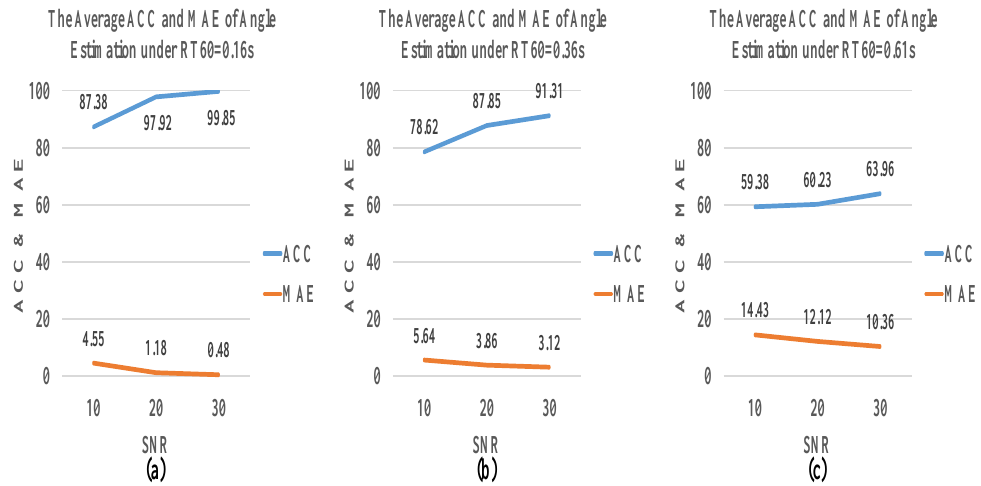
Figure 8. The average ACC and MAE of angle estimation by CNN-R in a multiple acoustic en- vironment where SNR = 10 dB, 20 dB, and 30 dB, and ( a ) RT60 = 0.16 s, ( b ) RT60 = 0.36 s, and ( c ) RT60 = 0.61